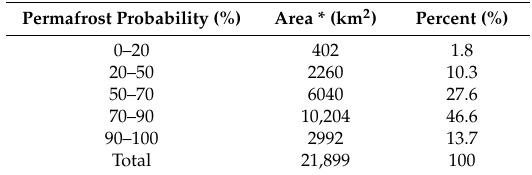
Table 6. Distribution of areas favorable for permafrost in the QTEC.